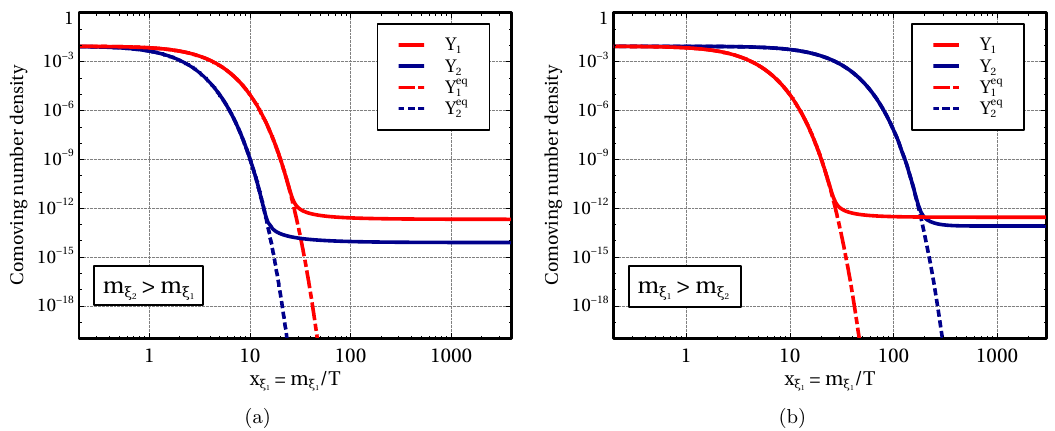
Figure 1 . Evolution of comoving number densities of both (cid:24) 1 and (cid:24) 2 for two cases (a) m (cid:24) (left panel) and (b) m (cid:24)